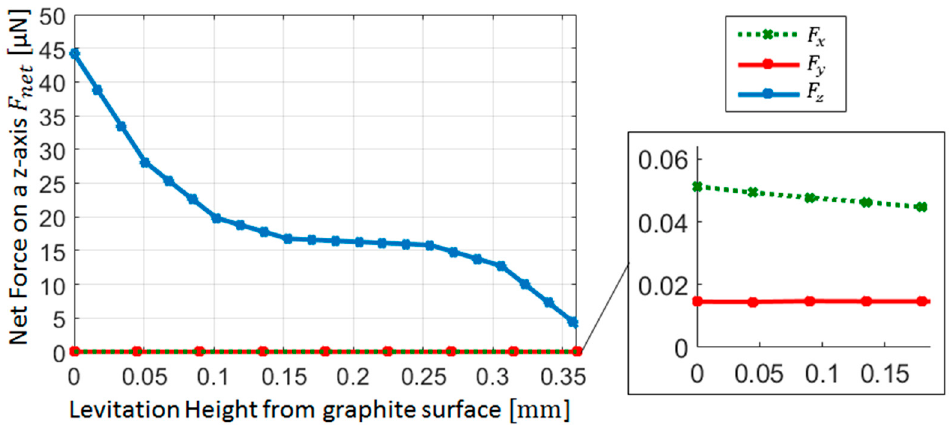
Figure 6. The net magnetic force characteristics acting on the micro-UFO for each one of the three axes vs to levitation distance. It has been shown that the x - and y -axis forces are in the 1/10 3 ratio according to the force value generated in the z -axis. However, when the acting forces on the x - and y -axes of the micro-UFO are small, 40–50 nN, the motion that occurs can be due to x , y forces being bigger than the drag force (Figure 5).